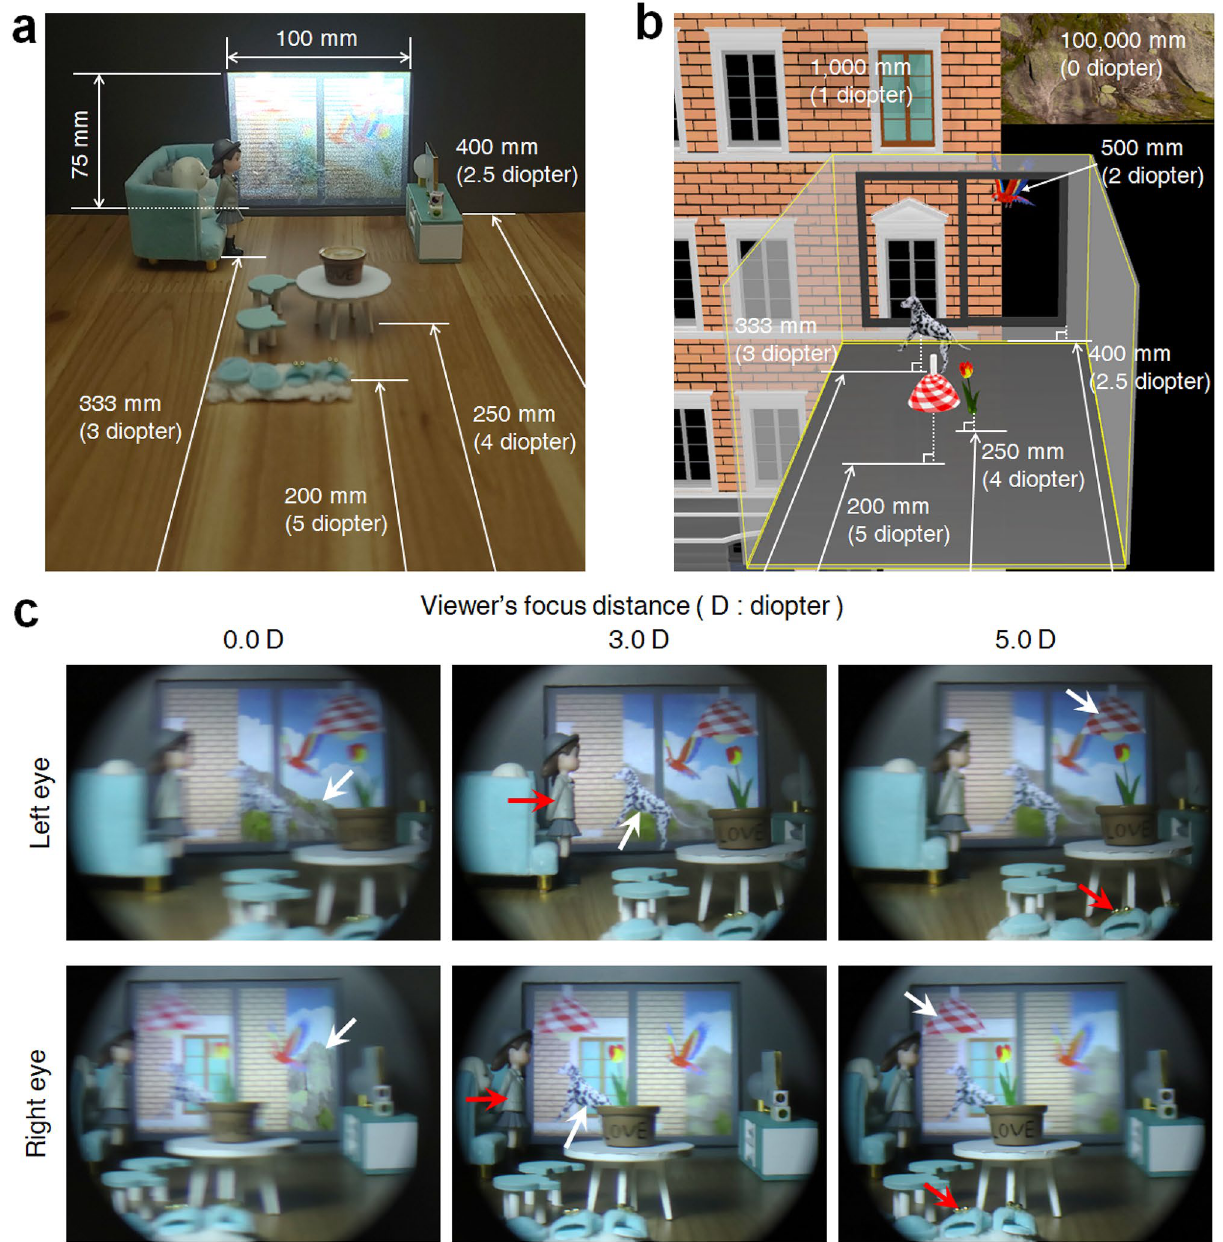
Figure 4. VAC-free AR images. Experimental configuration of ( a ) real objects and ( b ) virtual objects. ( c ) Reconstructed AR images. The AR images are measured by adjusting the focus distance through the binoculars to 0.0, 3.0, and 5.0